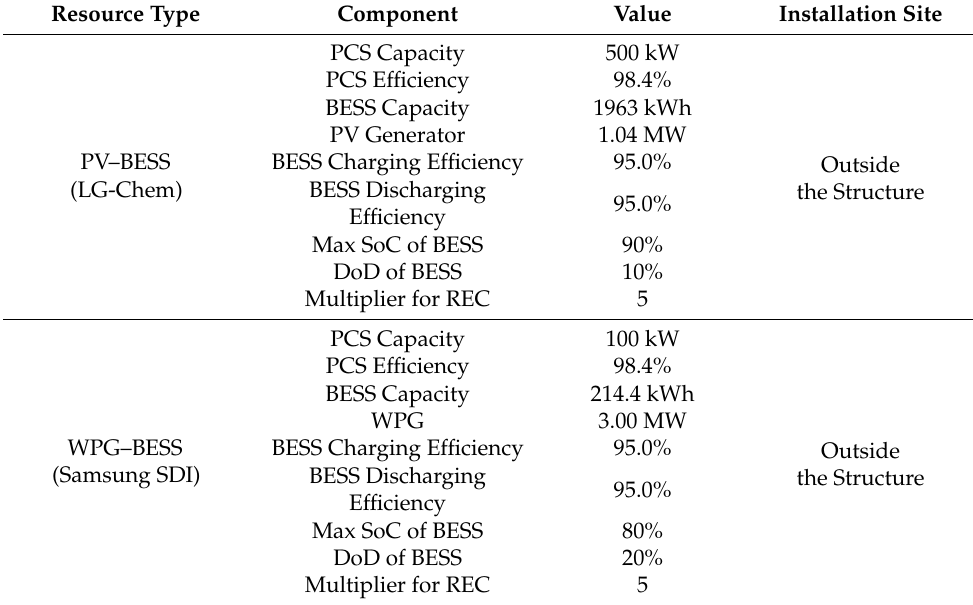
Table 4. Parameters of the coordinated